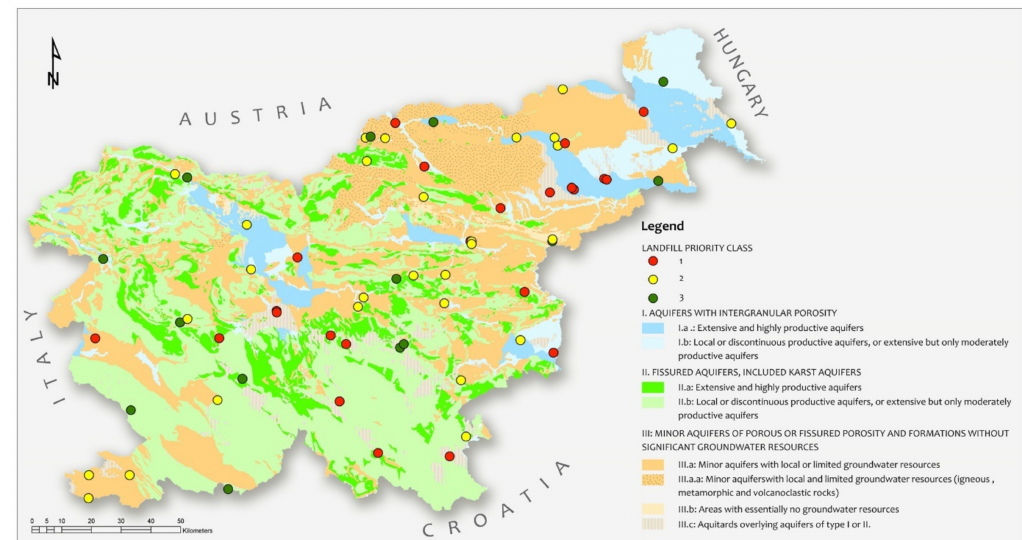
Figure 5. Distribution of priority classes for each